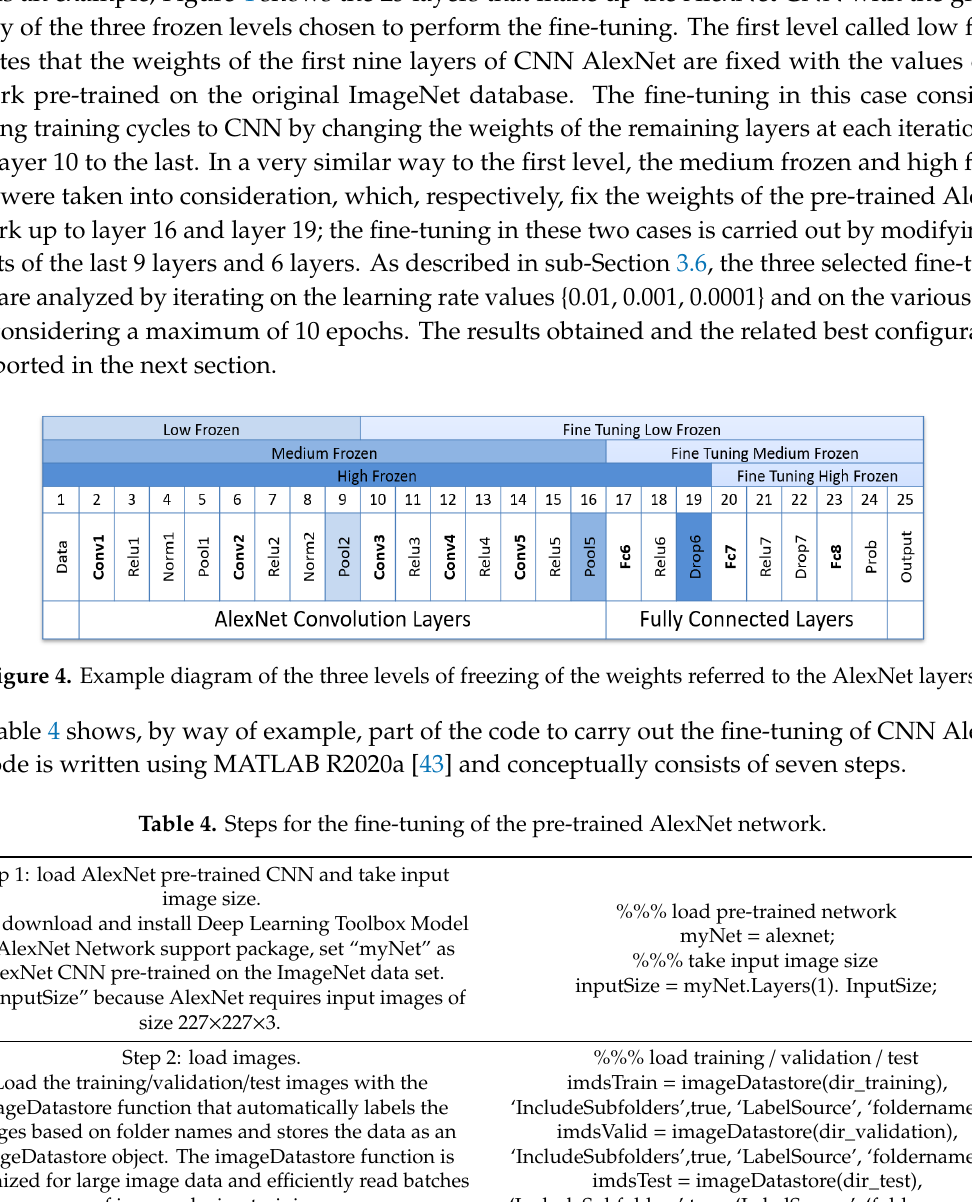
Table 3. Number of frozen layers at different levels and for the CNN analyzed.